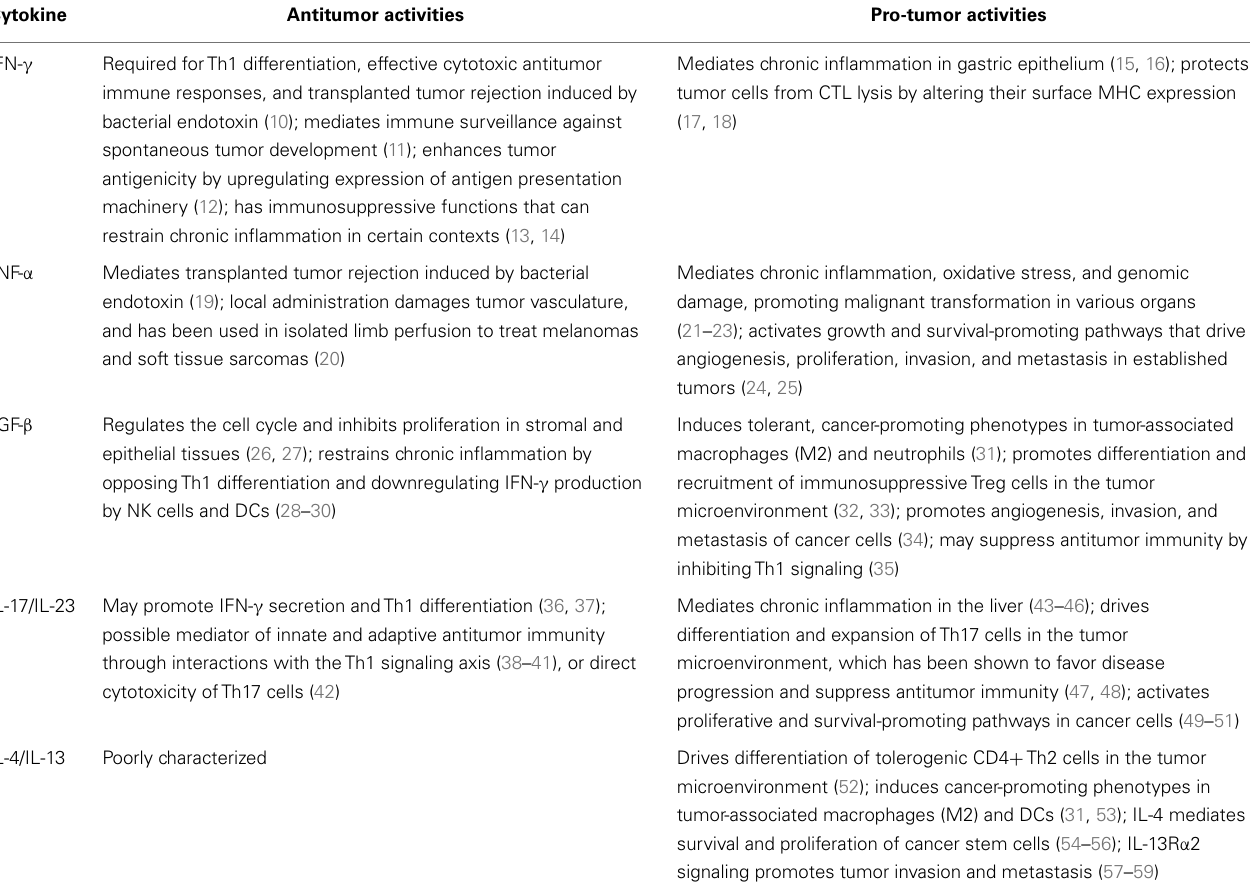
Table 1 |Anti- and pro-tumor activities of selected cytokines